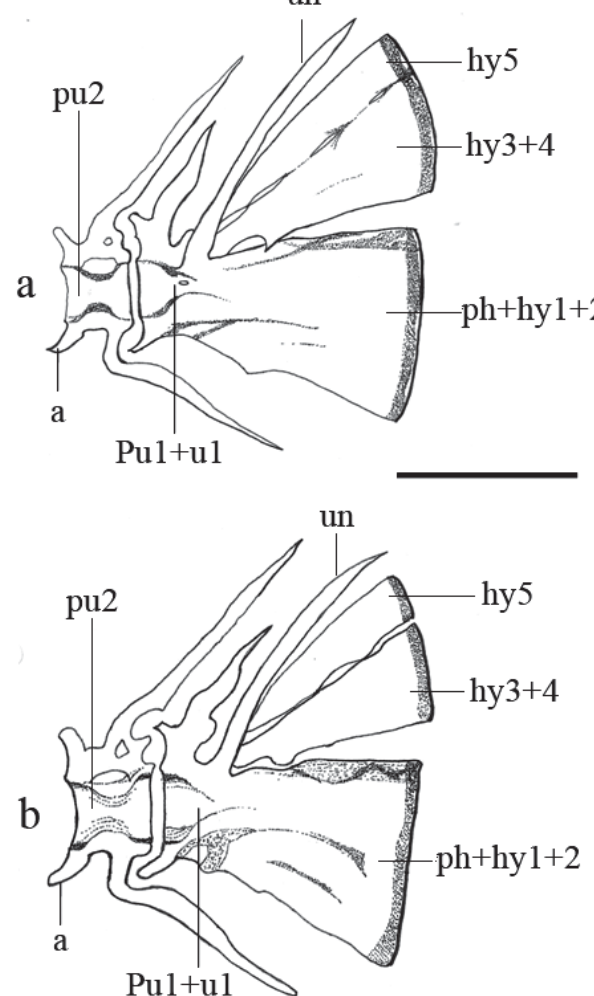
Fig. 8. Caudal skeleton of Trichomycterus uisae . a: CAC- CDMB 92, 28.3 mm SL, young specimen. b: CAC-CDMB 90, 41.1 mm SL, adult specimen. a: apophysis; hy 1-5: hypurals 1- 5; un: uroneural; ph: parhypural; pu1+u1: preural centrum 1+ural centrum 1; pu2: preural centrum 2. Scale bar = 1